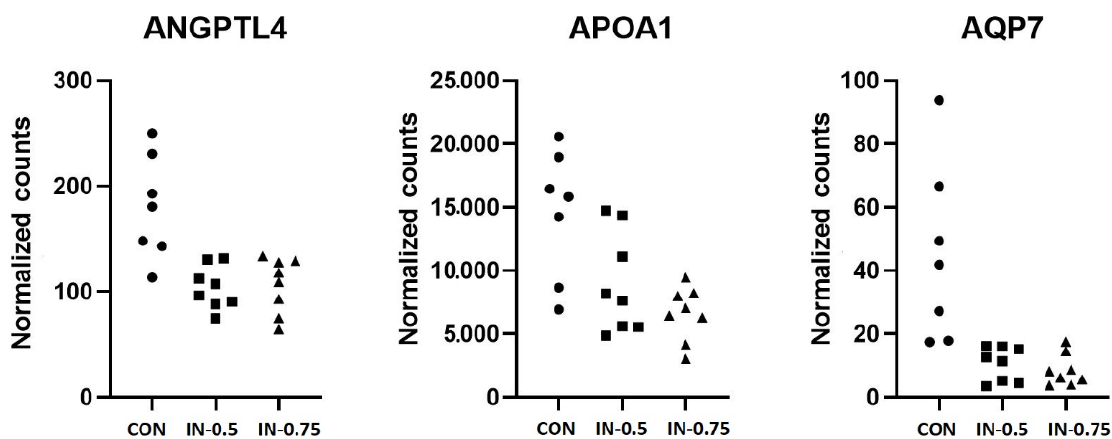
Figure 1. Normalized expression values from RNA-seq for the genes downregulated in the IN-0.75 group compared to the CON group and belonging to the PPAR pathway.